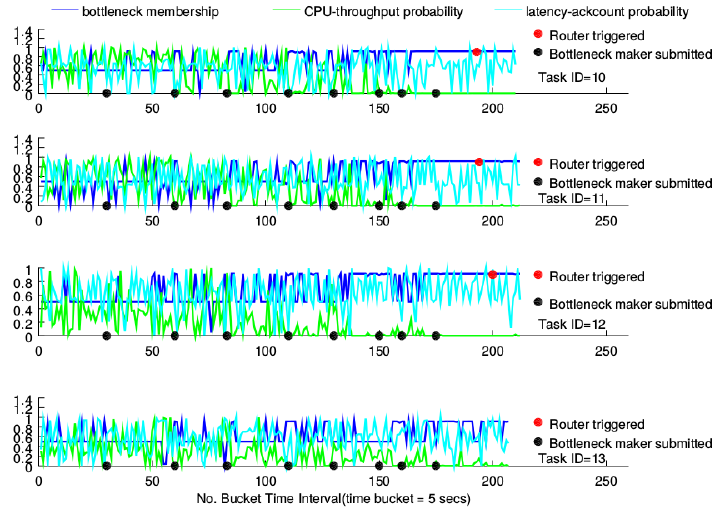
Figure 10. Router performance under the CPU-intensive bottleneck